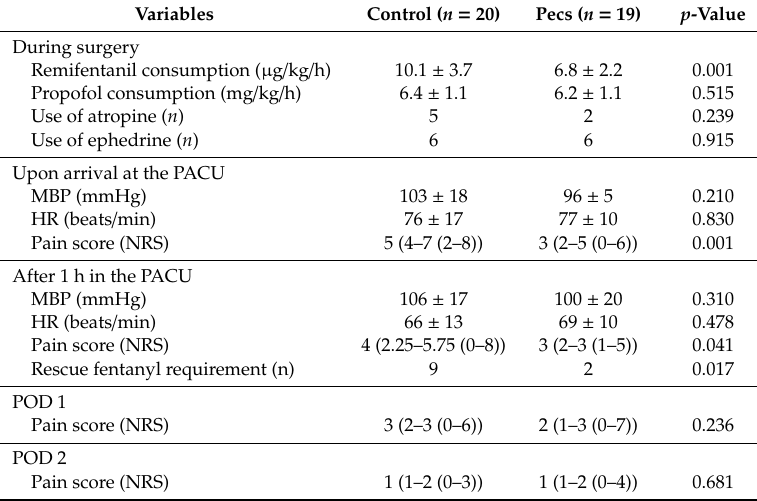
Table 2. Perioperative clinical data.